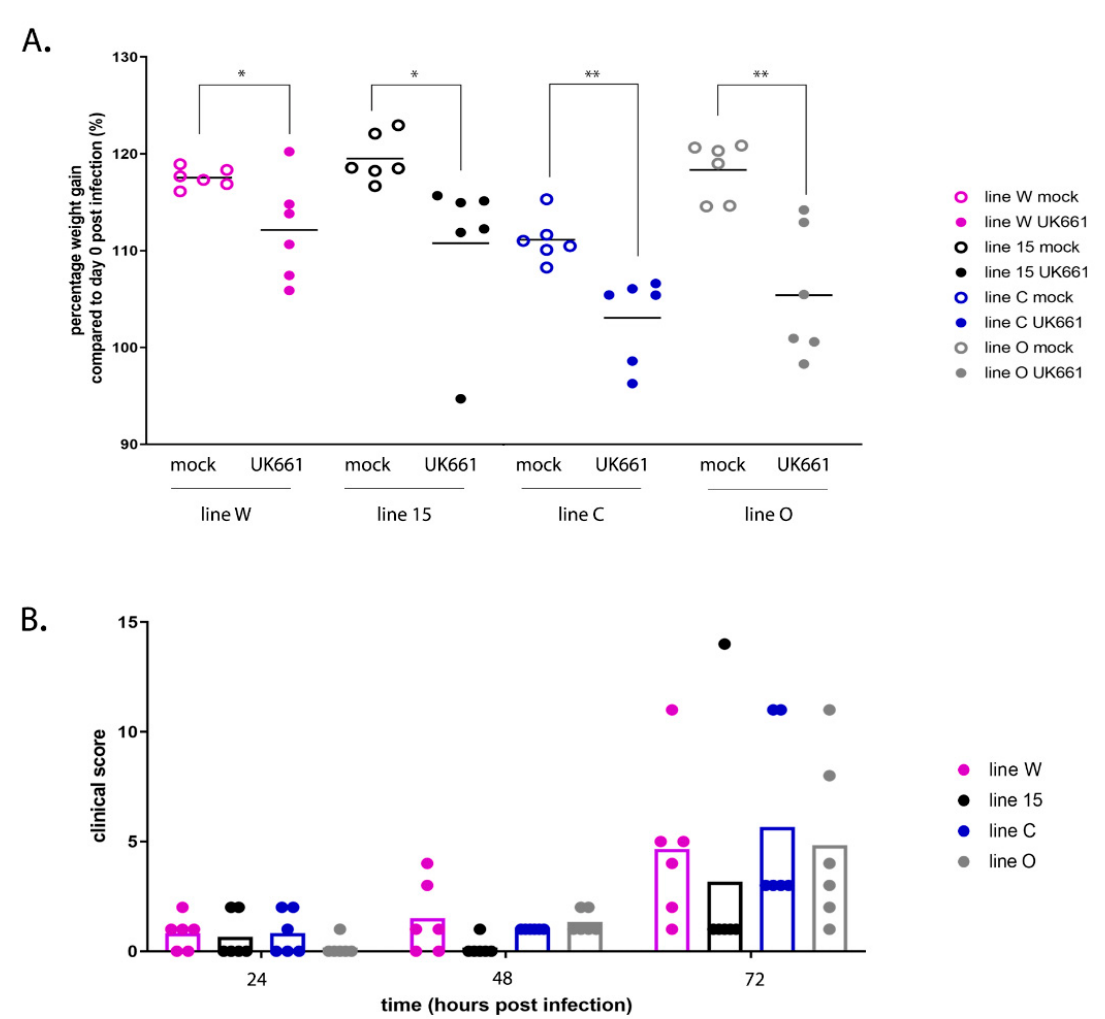
Figure 1. IBDV strain UK661 caused disease in all experimentally inoculated inbred lines with varying severity, but line 15 had milder clinical signs. Six birds at 2–3 weeks of age from each of lines W, 15, C and O were inoculated with 1.2 log 10 EID 50 of IBDV strain UK661 and six birds from each of these lines were mock-inoculated with PBS intranasally. Birds were weighed daily and the percentage weight gained at 3 dpi relative to the day of inoculation (day 0) was plotted for mock-infected birds (open circles) and IBDV-infected birds (closed circles) from lines W, 15, C and O ( A ). The clinical score was determined daily based on an in-house scoring system and plotted for each bird. Each dot represents one bird and each bar represents the average clinical score for the indicated line ( B ) (* p < 0.05, ** p < 0.01).